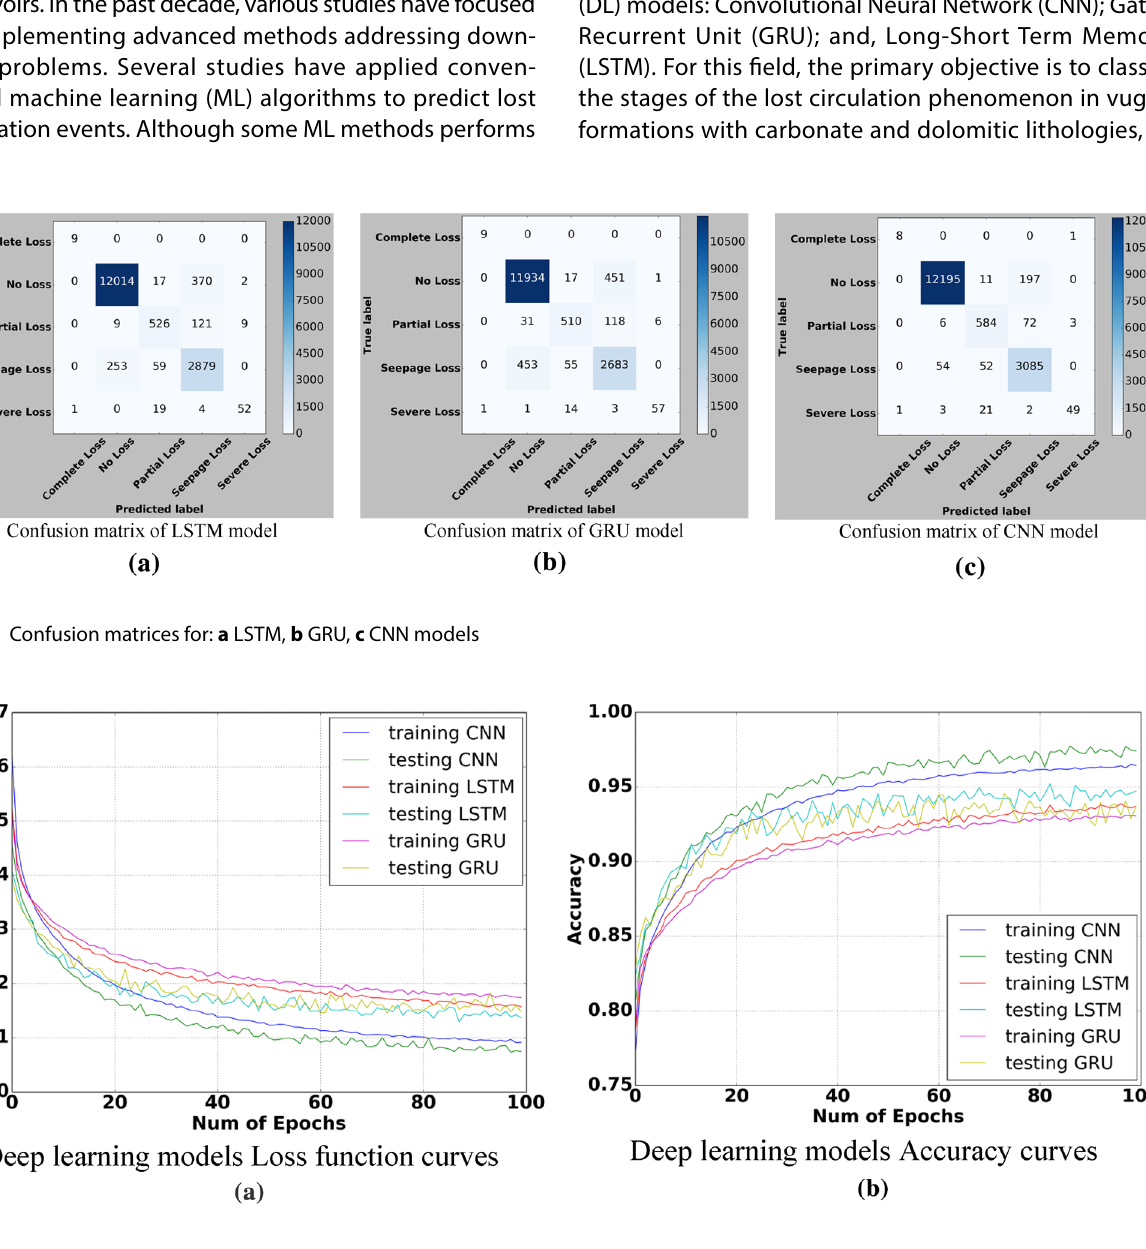
Fig. 13 Comparison summary of deep learning models applied to the Azadegan oilfield data set: a Loss function curves, b Accuracy